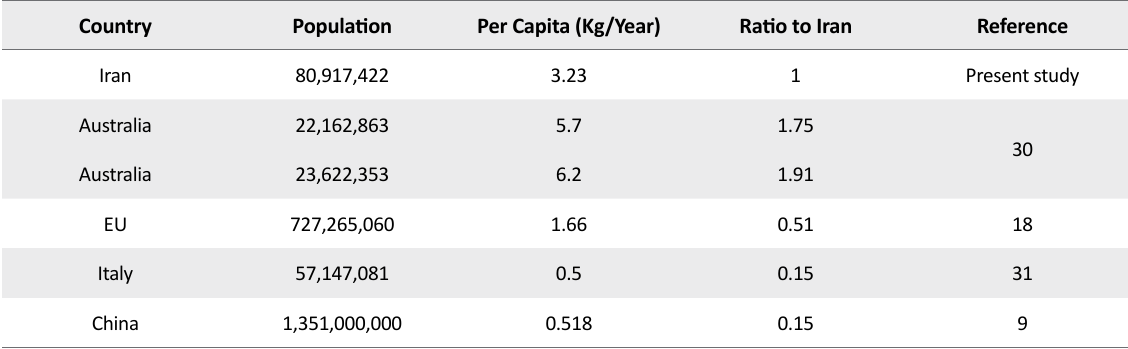
Table 4. Comparison of per capita battery use in different countries Country